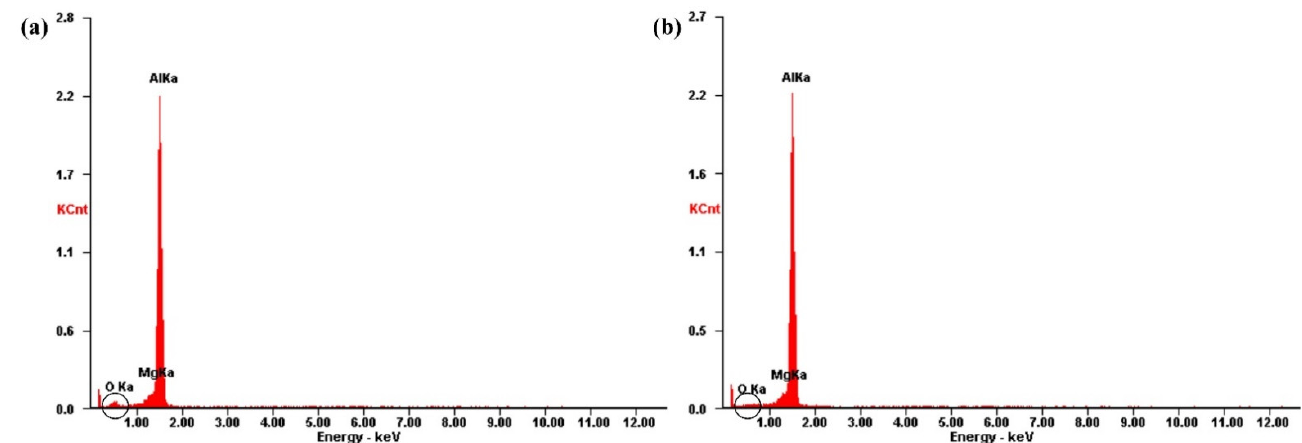
Figure 3. The results of EDS on the surface of samples: ( a ) untreated; ( b ) laser-cleaned.